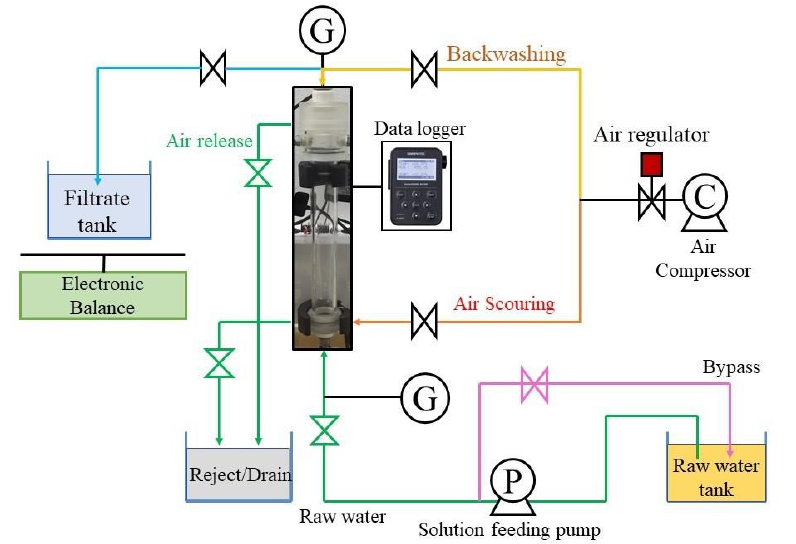
Figure 1. Schematic diagram of membrane filtration experiments. Notations: C denotes air compres- sor; G denotes digital pressure gauge; and P denotes pump. (Modified from “Operation Procedures for Laboratory Outside-in Filtration Test”, obtained via private communication with Kuraray Co., Ltd., Tokyo, Japan.)